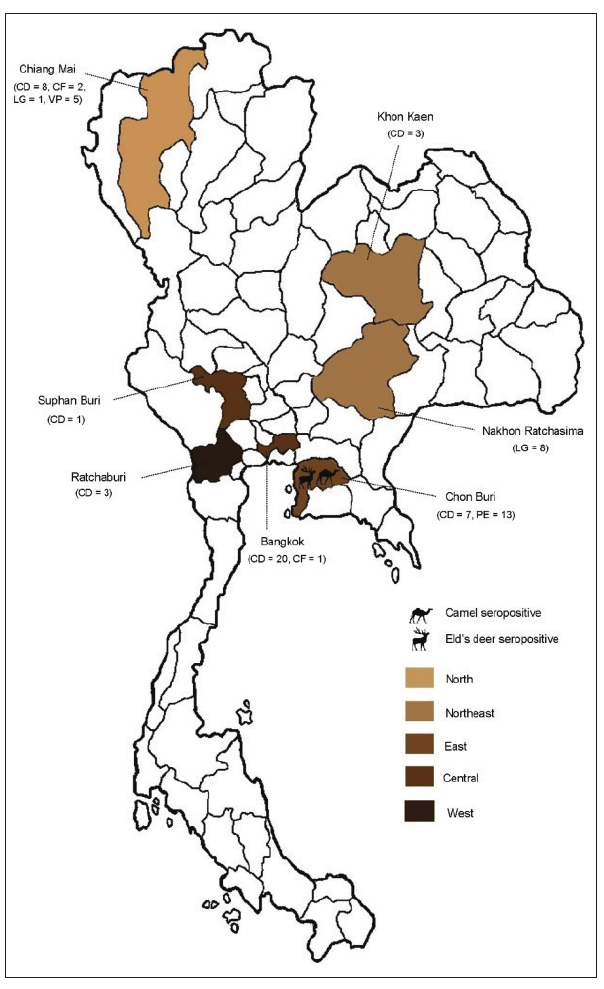
Figure-1: Map of Thailand depicting locations at which camelid species and Eld’s deer were collected. A number of samples derived from each animal species are indicated in the parentheses. Abbreviation: CD; Camelus dromedarius, CF; Camelus ferus, LG; Lama glama, PE; Panolia eldii , VP; Vicugna pacos [Source: https://commons.wikimedia.org/ wiki/File: